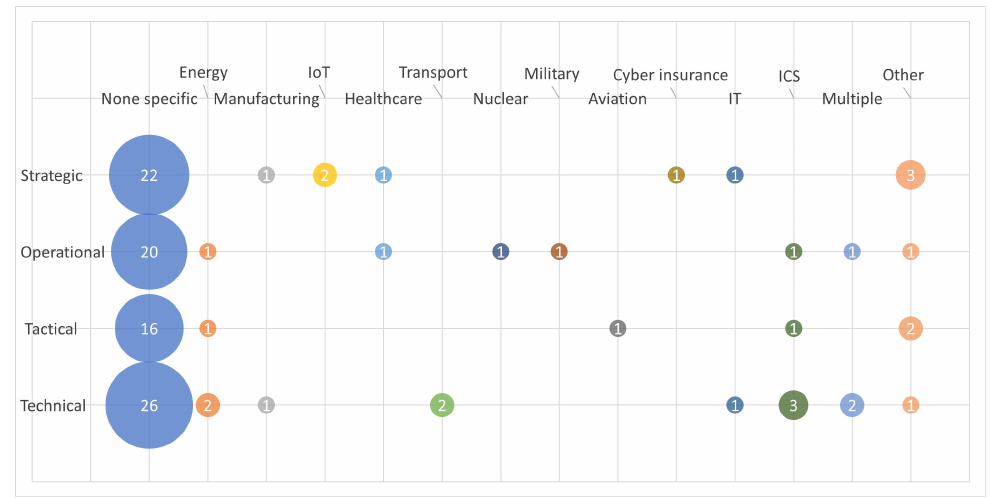
Figure 4. Data usage versus domain.